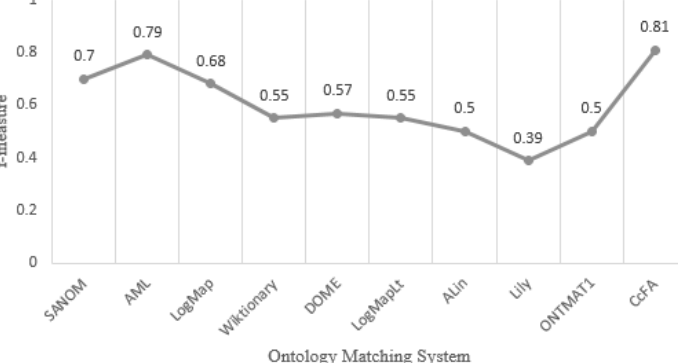
Figure 4. Comparison with state-of-the-art ontology matching systems on the Conference